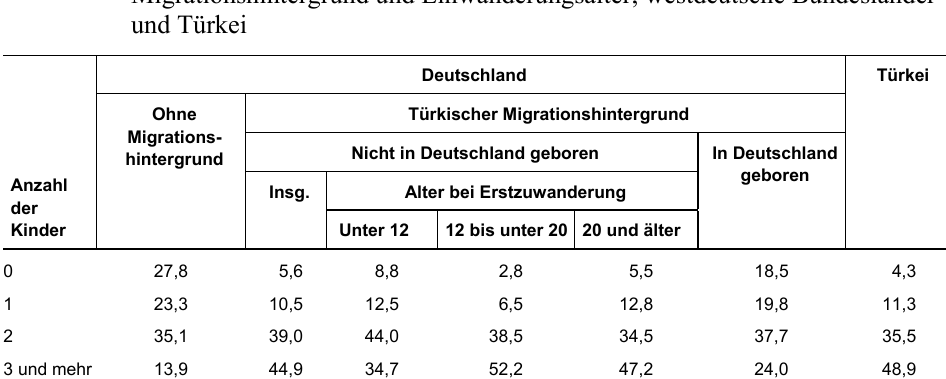
Tabelle 2 : Zahl der Geburten von Frauen im Alter von 35 bis 49 Jahren; nach Migrationshintergrund und Einwanderungsalter; westdeutsche